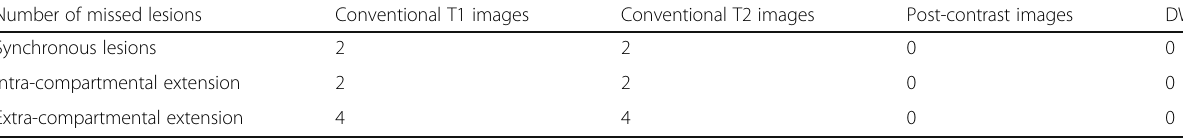
Table 3 Comparative analysis of T1 and T2 images vs. post-contrast and diffusion images Number of missed